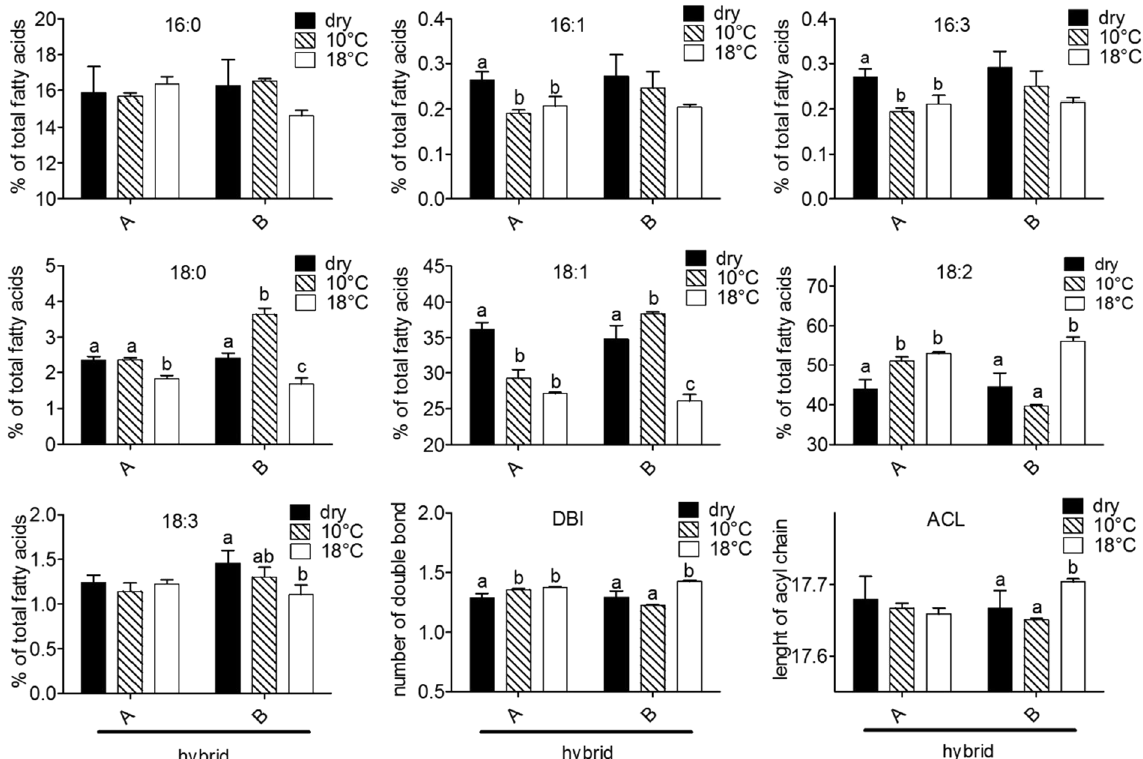
Figure 6. Fatty acid composition in phosphatidylcholine (PC). Proportion (in %) of fatty acid chains in dry and imbibed embryos of hybrids A and B. DBI: double bond index, ACL: acyl carbon length. Different letters denote significantly different mean values at P < 0.05 according to Tukey’s multiple range test. Absence of letters indicates that means are not significantly